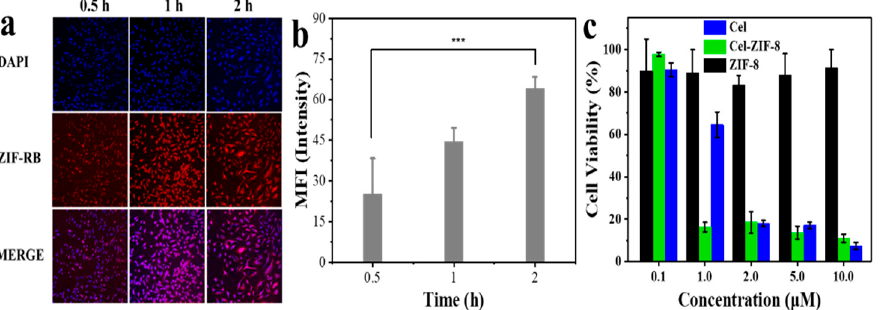
Figure 3. The uptake of Cel-ZIF-8 NPs by the human lung carcinoma A549 cells at 0.5, 1, and 2 h incubation times. ( a ) The CLSM images of A549 cells. The fluorescent dyes used were DAPI and RB. ( b ) The mean red fluorescence intensity (MFI) of A549 cells ( n = 5, *** p < 0.001, significantly different compared with control). ( c ) Cytotoxicity of Cel-ZIF-8, ZIF-8, and Cel at indicated concentrations after a 24-h co-incubation with A549 cells. The data are expressed as mean ± SD ( n = 5).